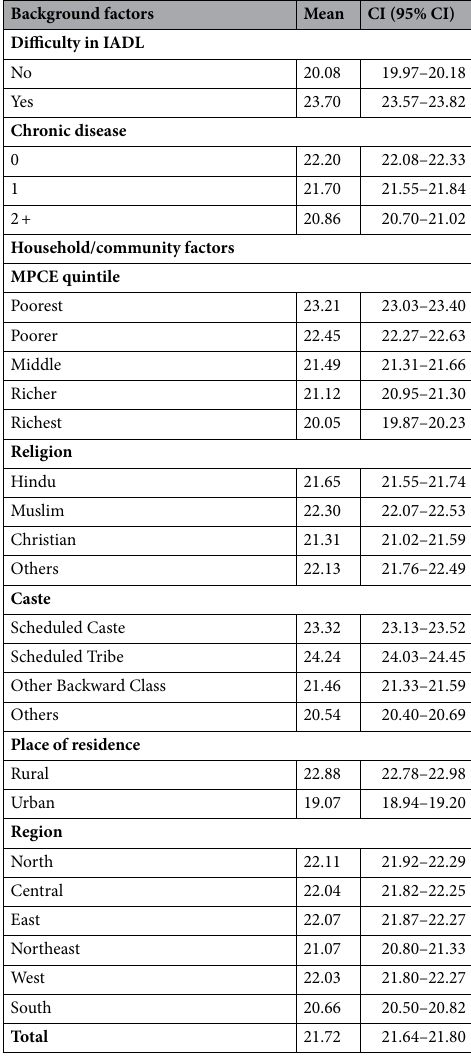
Table 2. Mean score of cognitive impairment among older adults by background characteristics, (n = 24,625). CI, Confidence interval; ADL, Activities of daily living; IADL, Instrumental activities of daily living; MPCE, Monthly per capita consumption expenditure; p value is based on chi-square